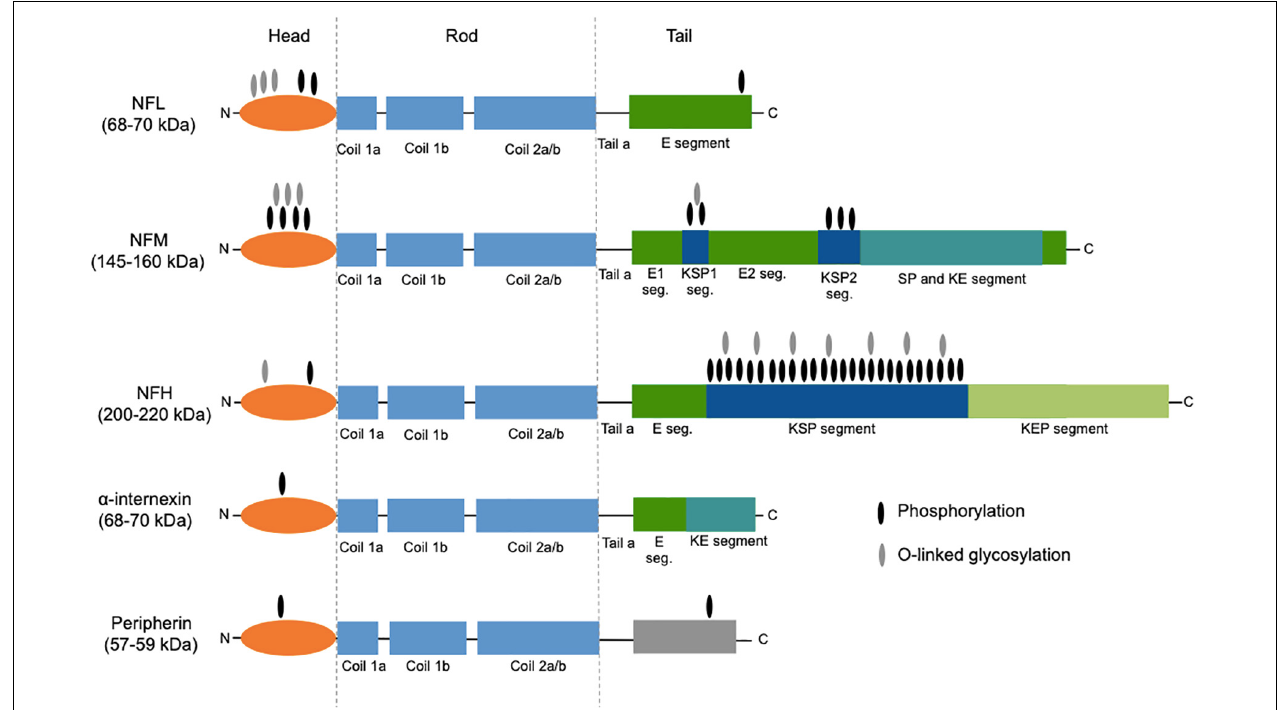
FIGURE 1 | Structure of neurofilament subunits. All neurofilament subunits share a common structure composed of a globular amino-terminal head domain, a central conserved α -helical rod domain (comprising several coiled coils), and a carboxy-terminal tail of variable length. NFM and NFH are characterized by long C-terminal tail domains rich in heavily phosphorylated serine-proline-lysine (KSP) repeats. The two main posttranslational modifications, namely, phosphorylation and O-linked glycosylation, are shown. The figure was created taking Figure 3 from Yuan et al. (2017) as model, with the authors’ permission. NFL, neurofilament light chain; NFM, neurofilament middle chain; NFH, neurofilament heavy chain; E segment (seg.), glutamic acid-rich segment; KSP, lysine-serine-proline; SP, serine-proline; KE, lysine-glutamic acid; KEP, lysine-glutamic